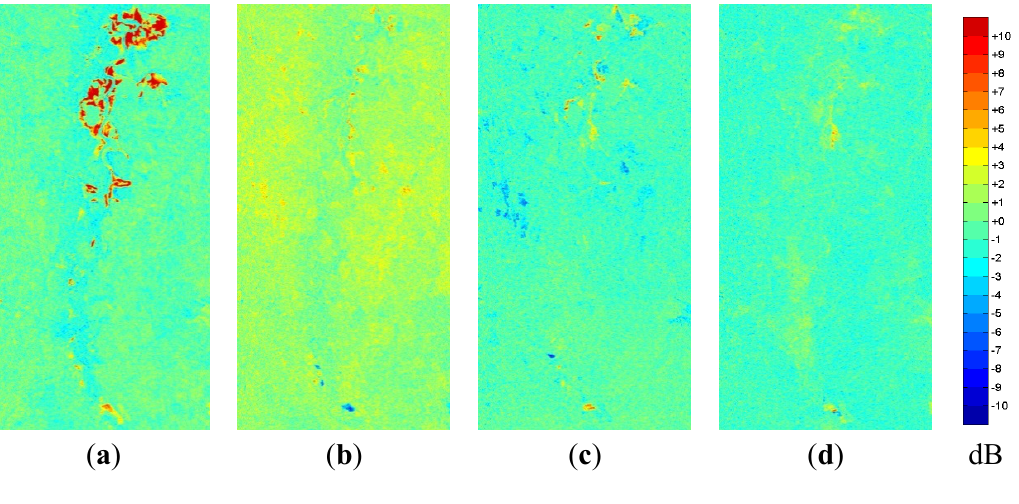
Figure 9. Change in volume scattering intensity according to the Freeman-Durden decomposition between sequent acquisitions scaled to decibel values: ( a ) April to May; ( b ) May to June; ( c ) June to July; and ( d ) July to August.